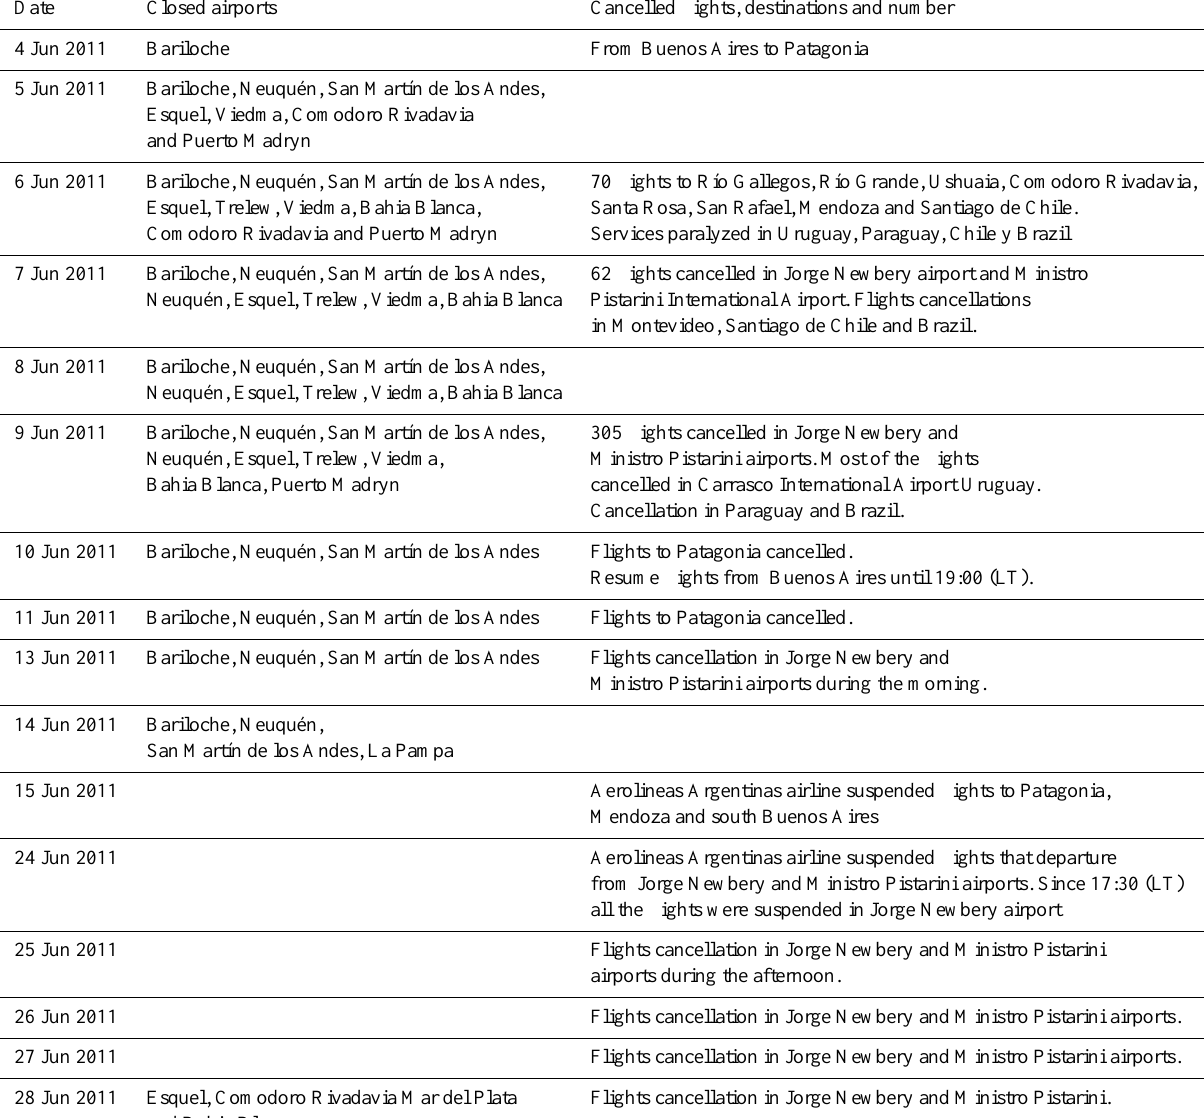
Table 3. Summary of number of closed airports and flights cancelled for the month of June